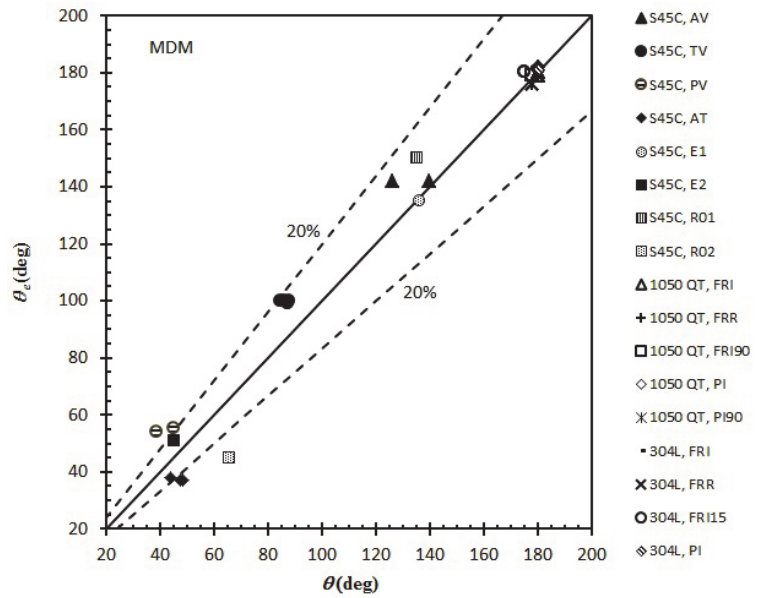
Figure 4: Comparison of observed and predicted orientation of crital plane by the MDM.